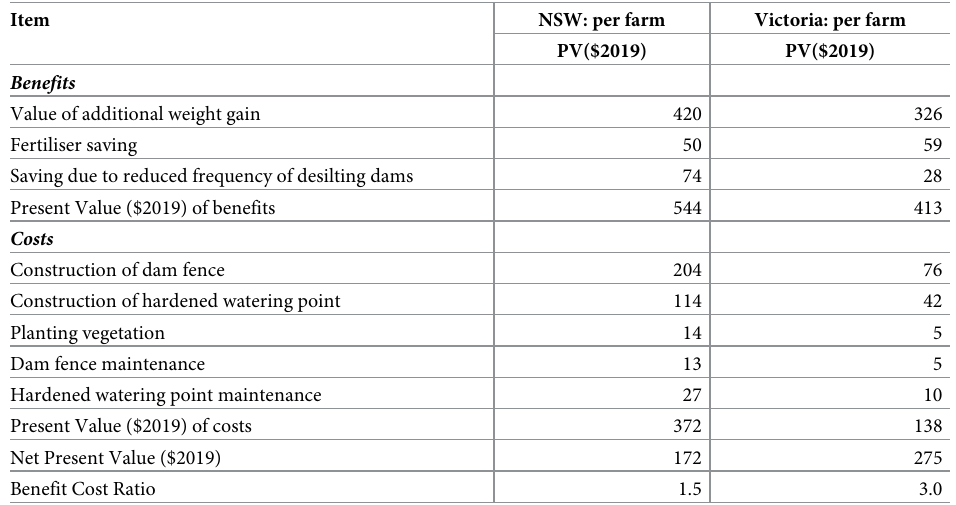
Table 3. Deterministic analysis of per farm Net Present Value (NPV) of renovating dams on beef cattle farms in NSW and Victoria over a 50-year period. ($’000). Item NSW: per farm Victoria: per